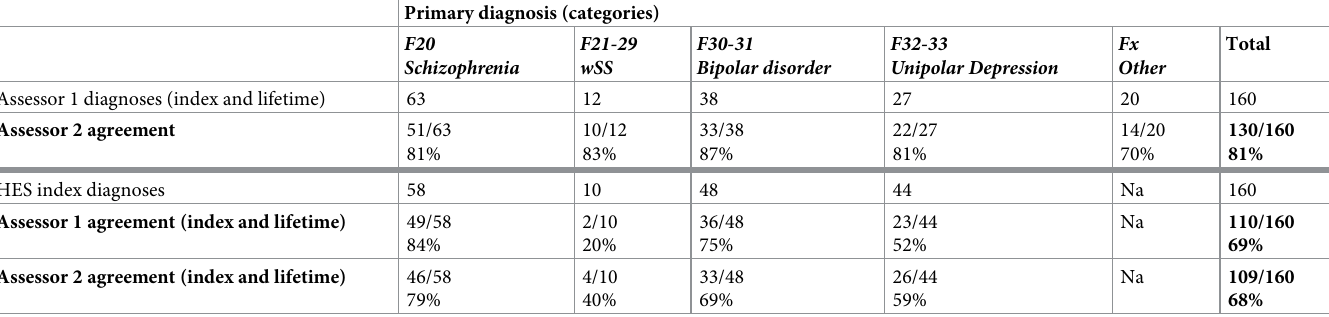
Table 4. Inter-rater reliability for primary diagnoses of index and lifetime formulations in 80 cases (160 formulations).